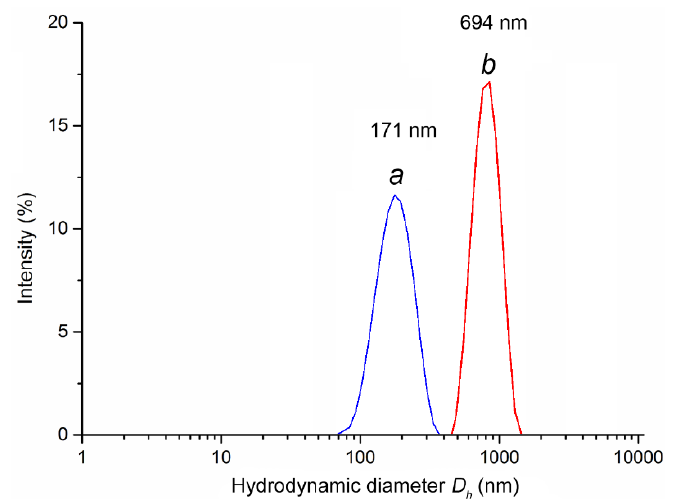
Figure 8. Histogram of the distribution over the hydrodynamic diameter D h of the scattering